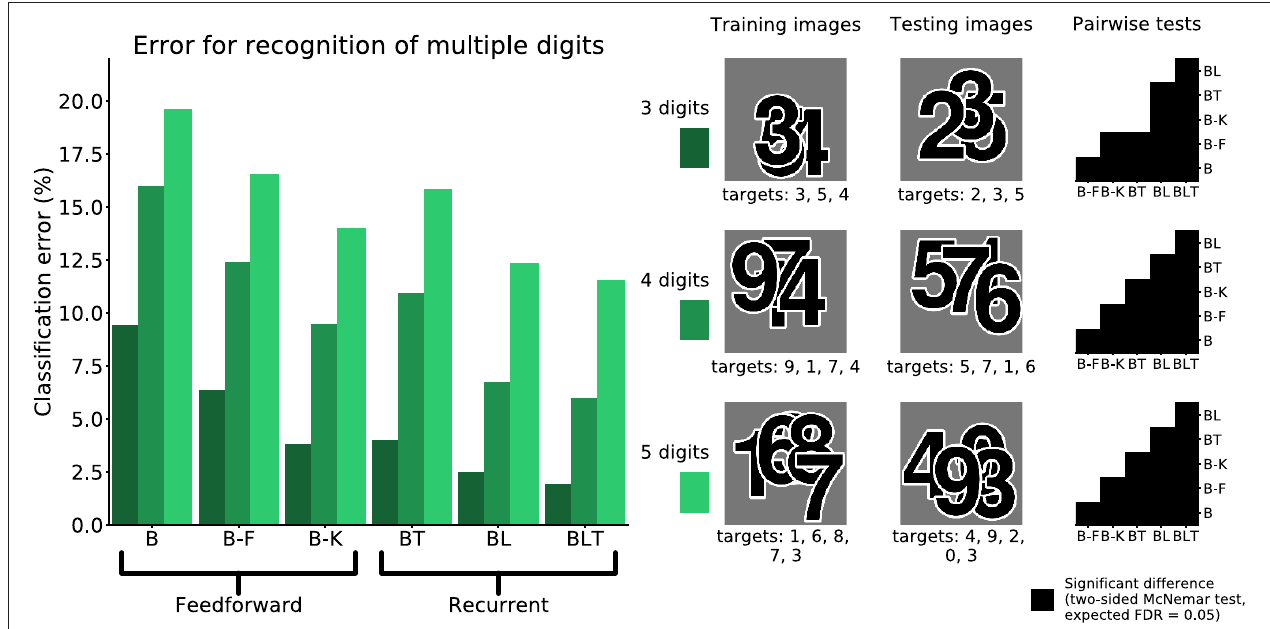
FIGURE 7 | Classification error for all models on multiple digit detection with varying numbers of digits. Examples of the images used to train and test the networks are also shown. Matrices to the right indicate significant results of pairwise McNemar tests. Comparisons are across models and within image sets. Black boxes indicate significant differences at p < 0.05 when controlling the expected false discovery rate at 0.05.